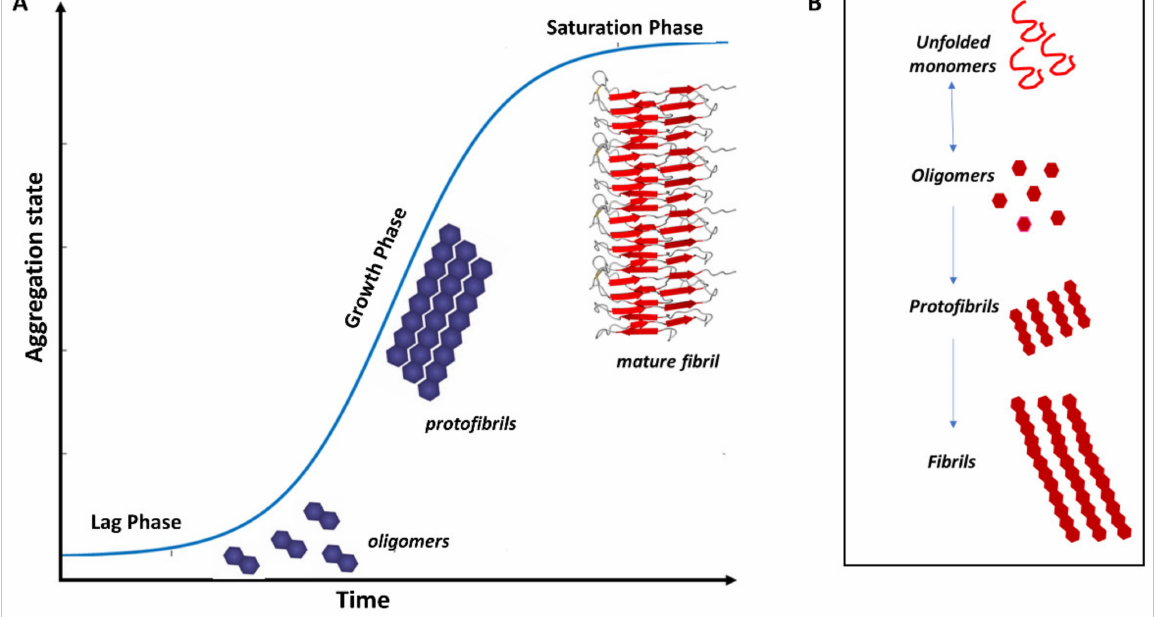
Figure 3. Schematic representation of the amyloid aggregation process. ( A ) Aggregation kinetics of misfolded proteins: the sigmoidal curve represents the temporal evolution of a fluorescent signal. ( B ) Under pathological conditions, natively unfolded monomers are able to self-aggregate in pathological oligomers (primary nucleation). Thus, oligomers can be extended into protofibrils (secondary nucleation) and mature